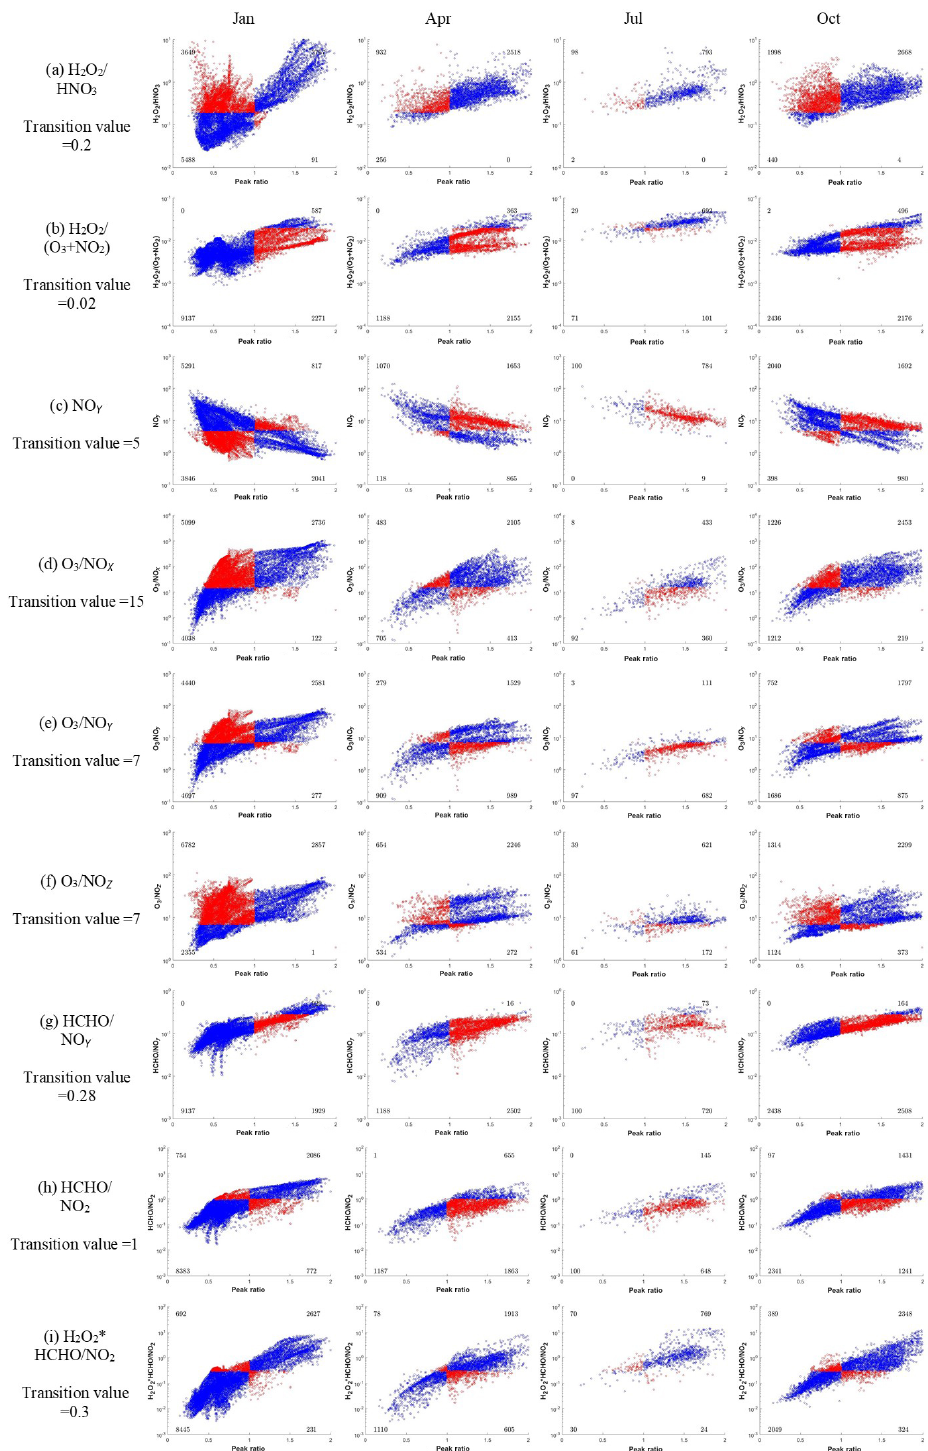
Figure 4. Performance of observable indicators in predicting O 3 chemistry. The x axis represents the PR values where the transition value is 1, and the y axis represents the observable indicators. The blue dots represent the grids where O 3 chemistry is successfully predicted by the observable indicator; the red dots represent the grids where the observable indicator fails to predict O 3 chemistry. The numbers in the four corners represent the grid number in each section; the number in July is much lower than those in the other months because most grids are located at the NO x -limited regime with PR > 2 in